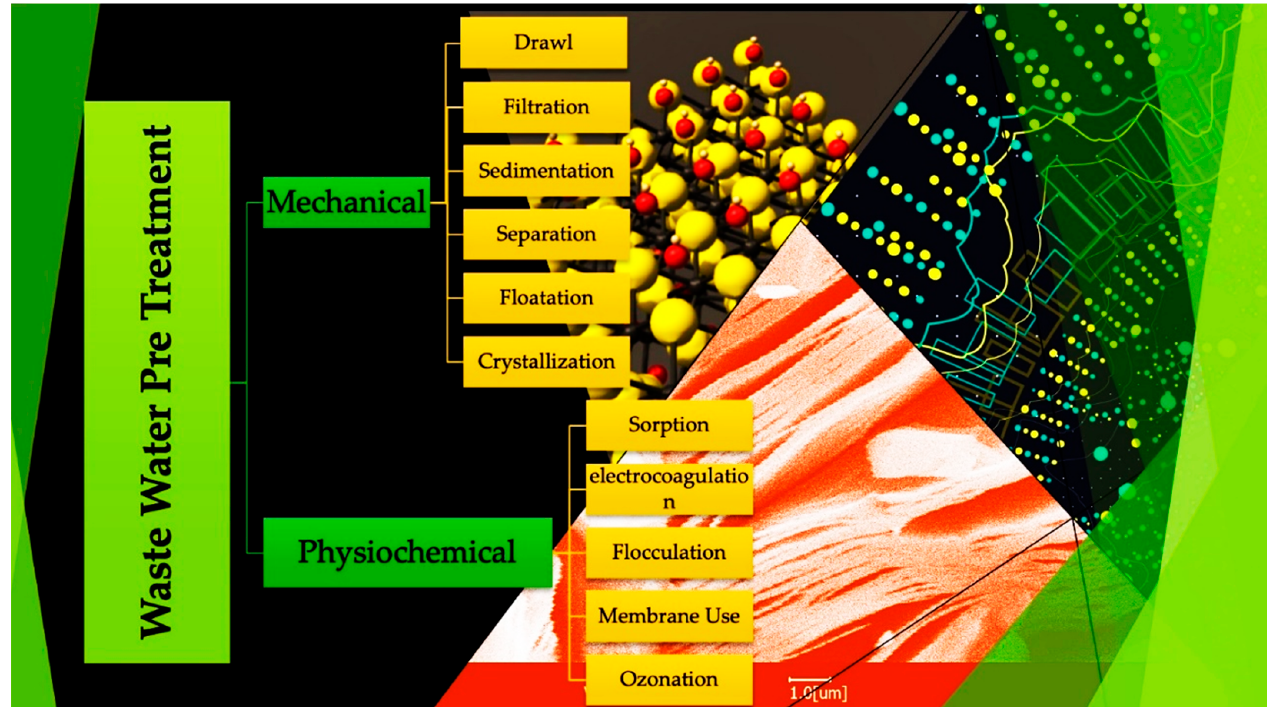
Figure 5. Preliminary removal methods of contaminants from wastewater [118].